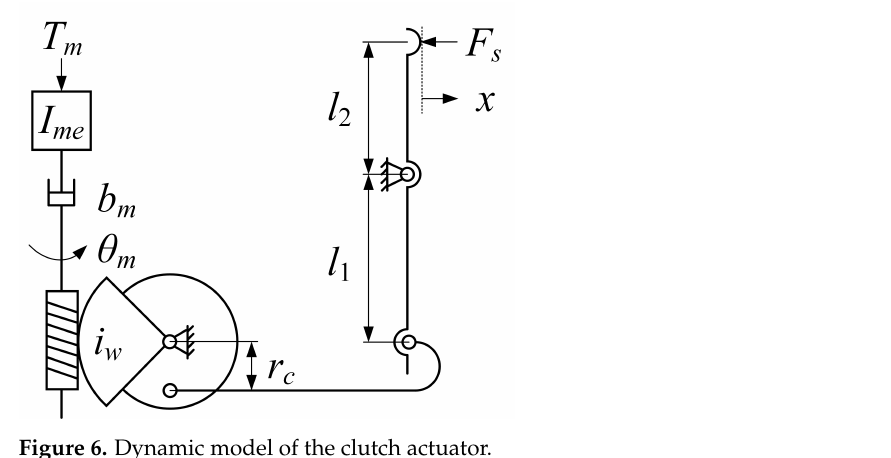
Figure 6. Dynamic model of the clutch